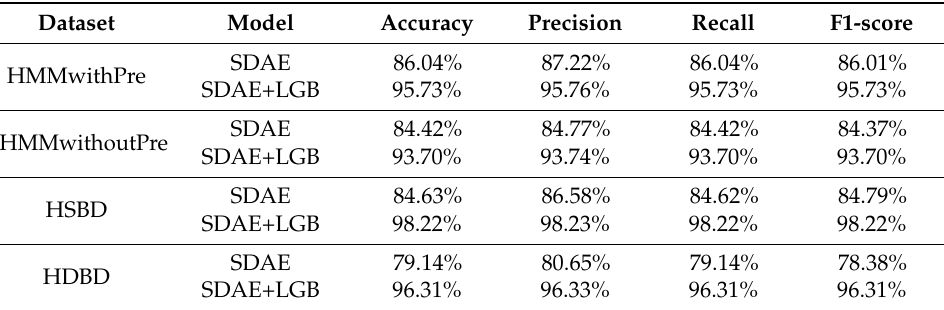
Table 9. The evaluation score of single SDAE on four